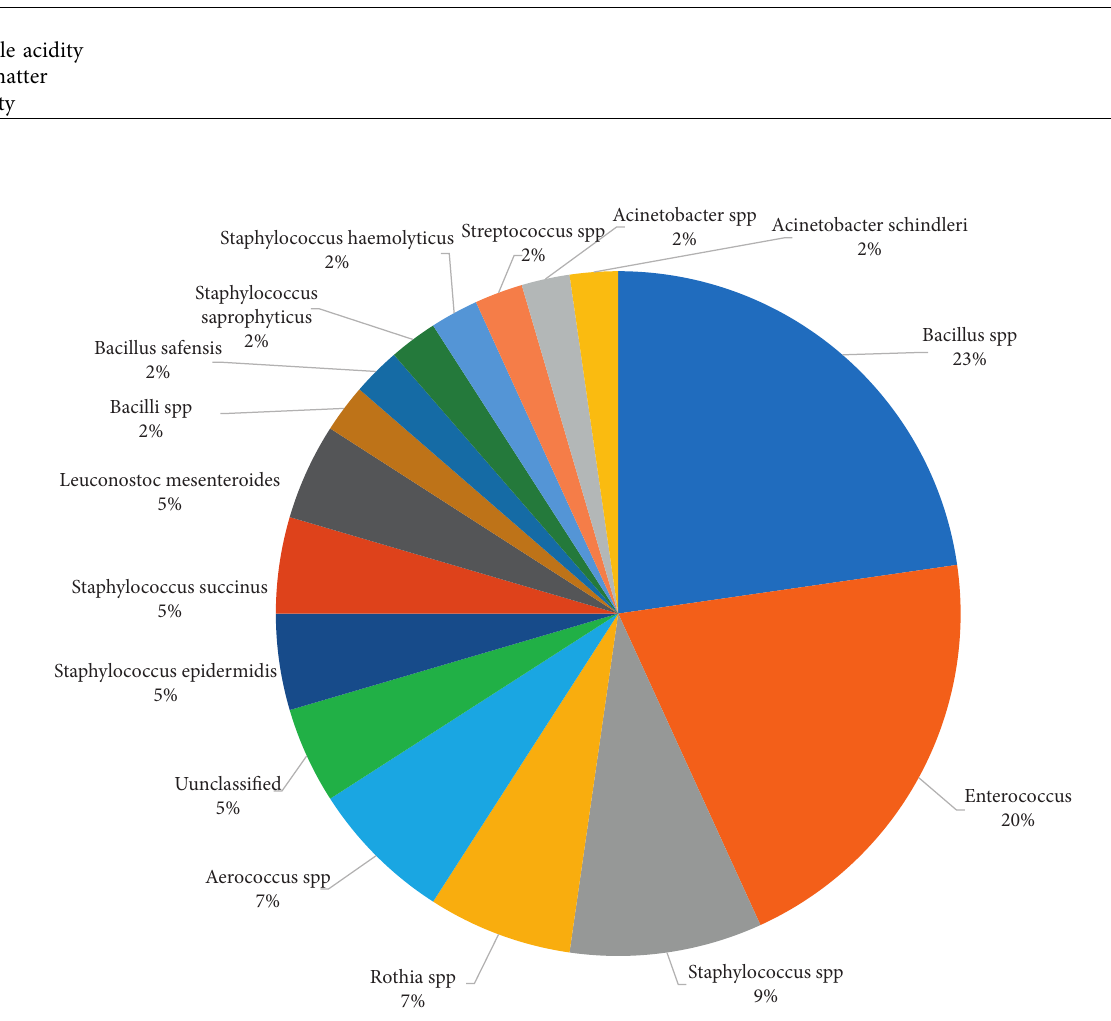
Figure 1: Taxonomic inference of donkey milk bacteria and the relative abundance of recovered